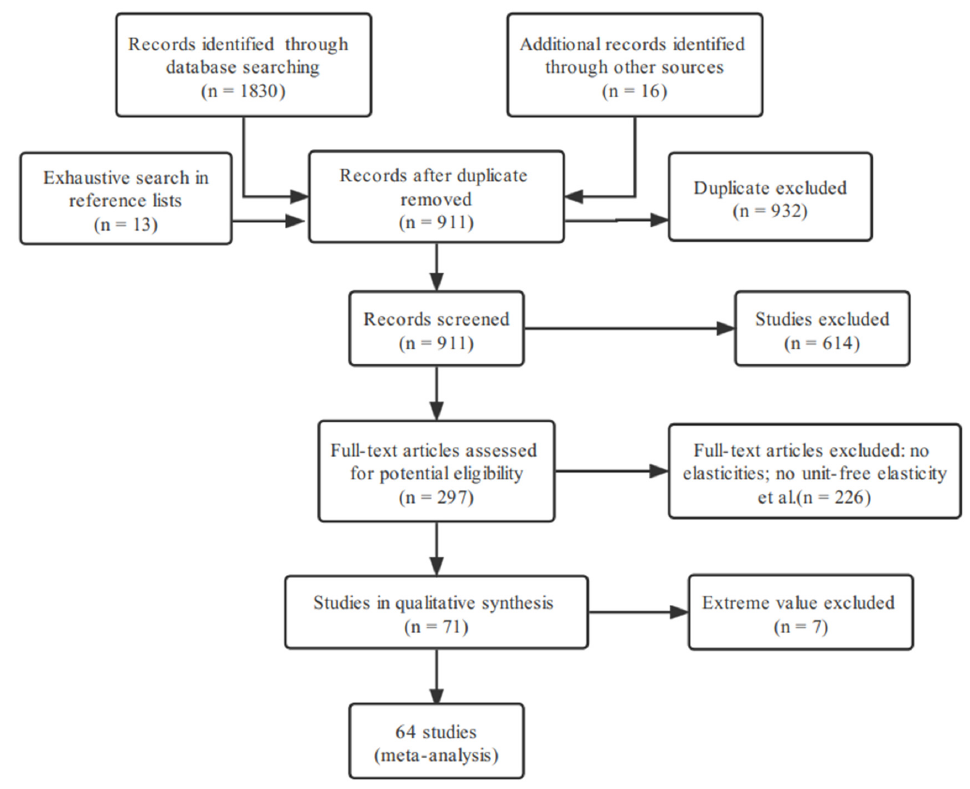
Figure 3. Selection of primary studies and construction of meta-sample.